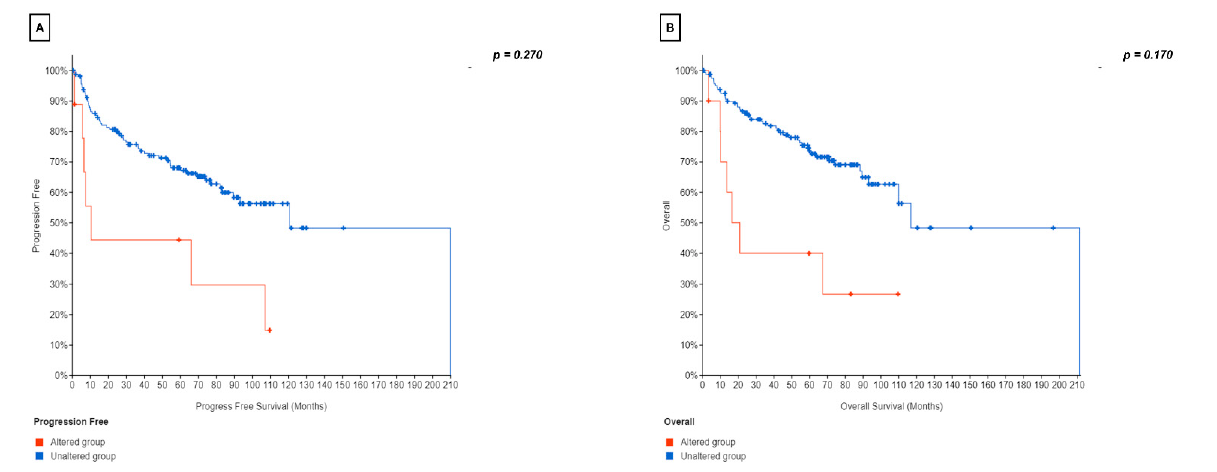
Figure A1. Univariate analysis of Progression Free Survival ( A ) and Overall Survival ( B ) regarding EZH2 status. EZH2 mutated DLBCL is associated with worse Overall and Progression Free Survival, albeit not significantly. Data and graphs were generated from the platform cBioPortal [4] and comprise 237 patients included in two studies (DFCI, Nat Med 2018; TCGA, PanCancer Atlas) with publicly available information regarding EZH2 status and follow-up.